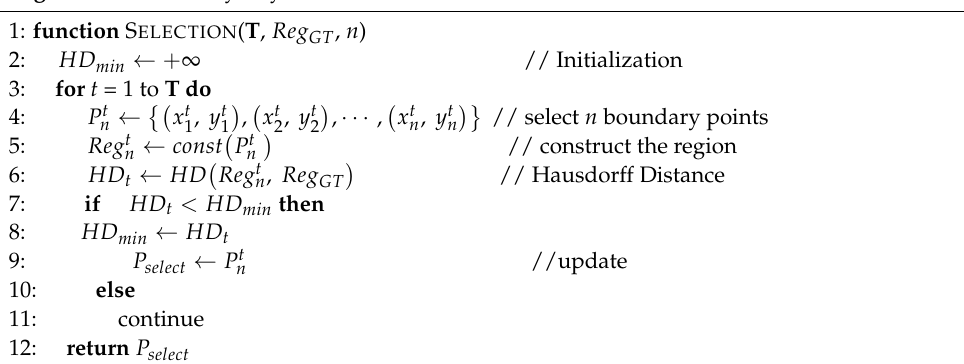
Algorithm 1 Boundary Key Points Selection